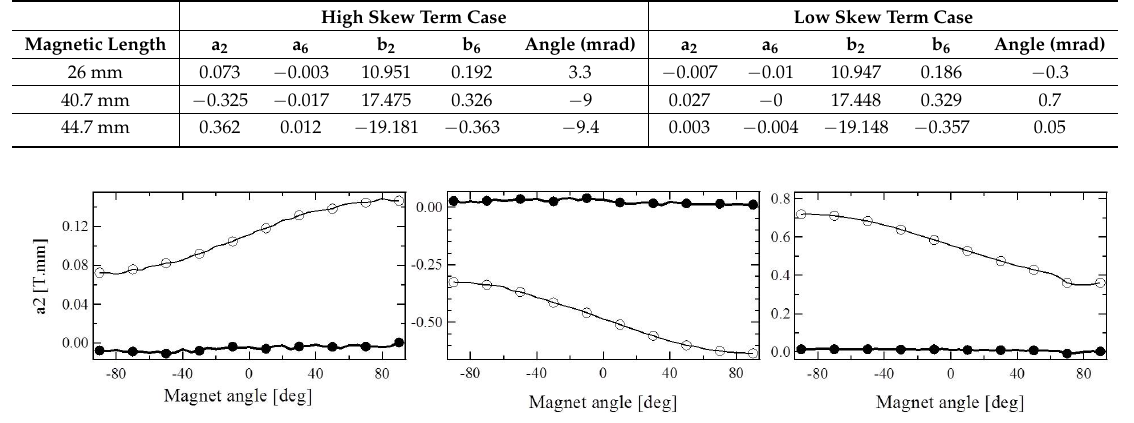
( a ) QUAPEVA magnetic design with different orientation of the cylindrical magnets: maximum ( left ), intermediate ( middle ), minimum gradient ( right ). ( b ) Mechanical shims applied to one of the QUAPEVAs to compensate for the skew terms. Table 2. Multipolar terms before (high skew terms case) and after (low skew terms case) correction.